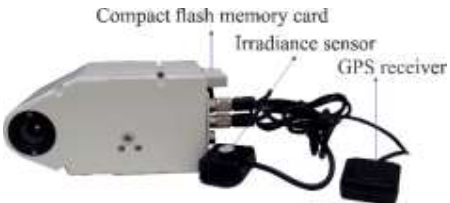
Figure 1. Hyperspectral camera based on a Piezoactuated